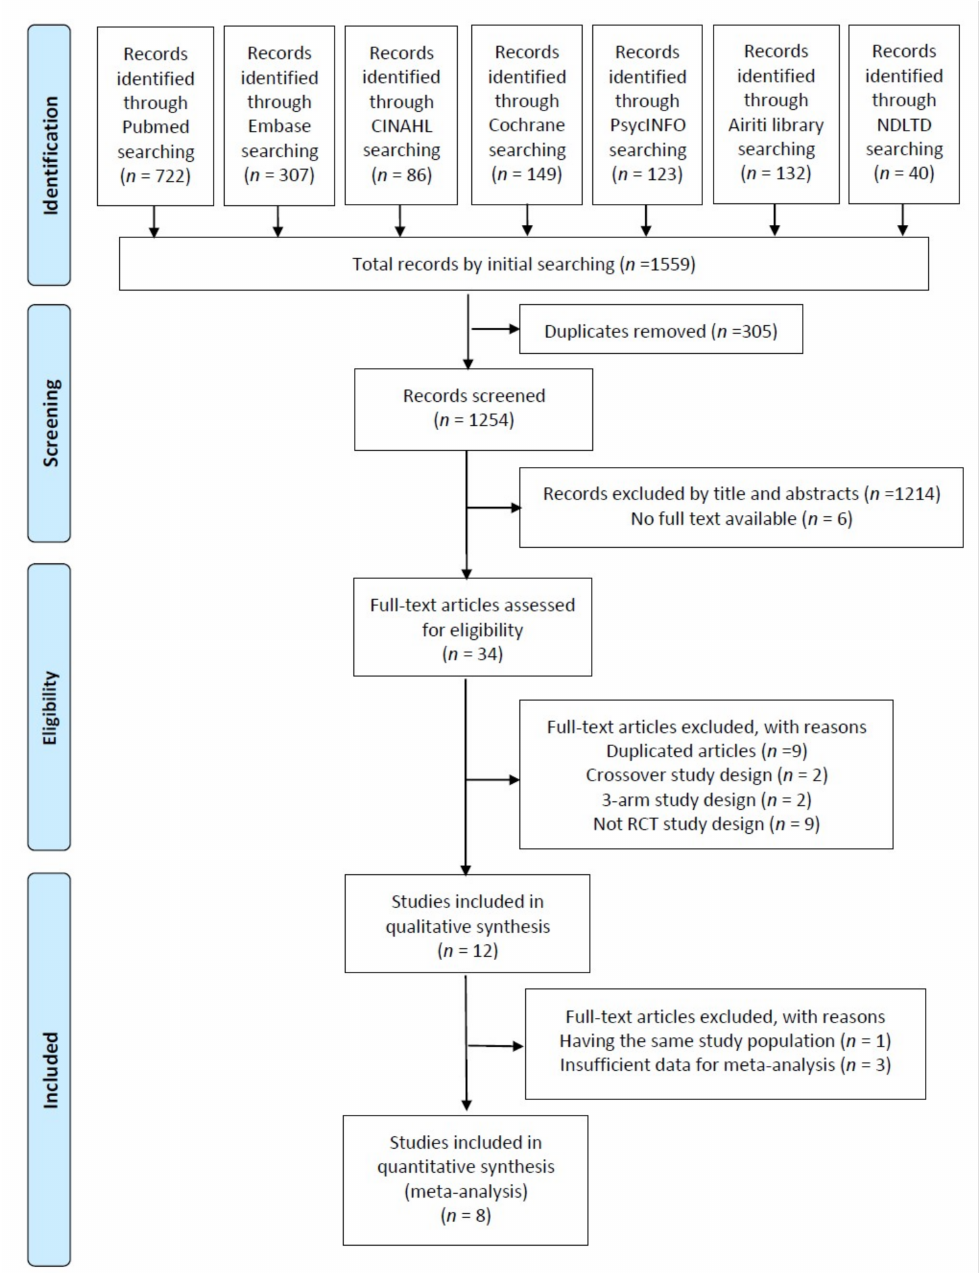
Figure 1. Flowchart of the study selection process. CINAHL, Cumulative Index to Nursing and Allied Health Literature; NDLTD, the net worked digital library of theses and